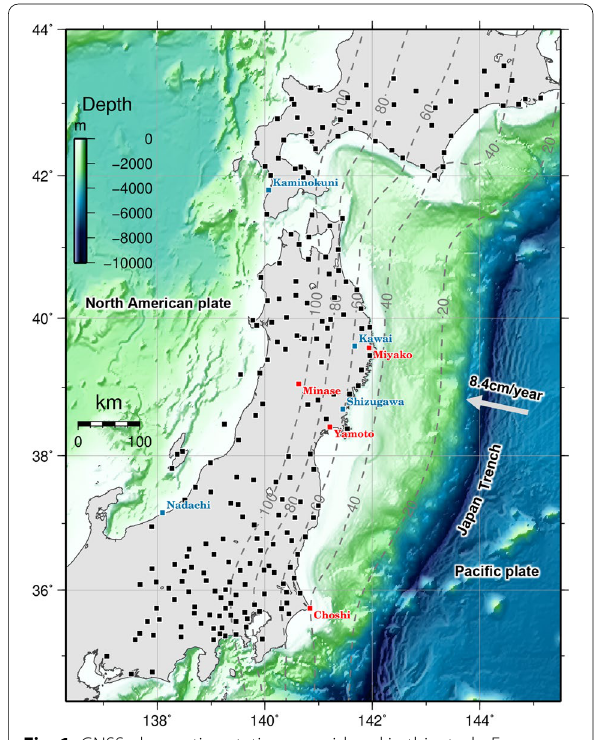
Fig. 1 GNSS observation stations considered in this study. Four stations marked as red squares were used for predicting the time series. Four stations marked as blue squares are used in Figs. 2, 3, and 6, and the stations marked as black squares are the other stations used in this study. Gray area represents land, and a seafloor topographic map is depicted. Gray arrow depicts the horizontal displacement rate observed at the sea bottom after the 2011 Tohoku-Oki earthquake (Honsho et al. 2019). Isodepth contours of the Pacific slab were estimated by Kita et al. (2010), Nakajima and Hasegawa (2006), and Nakajima et al.